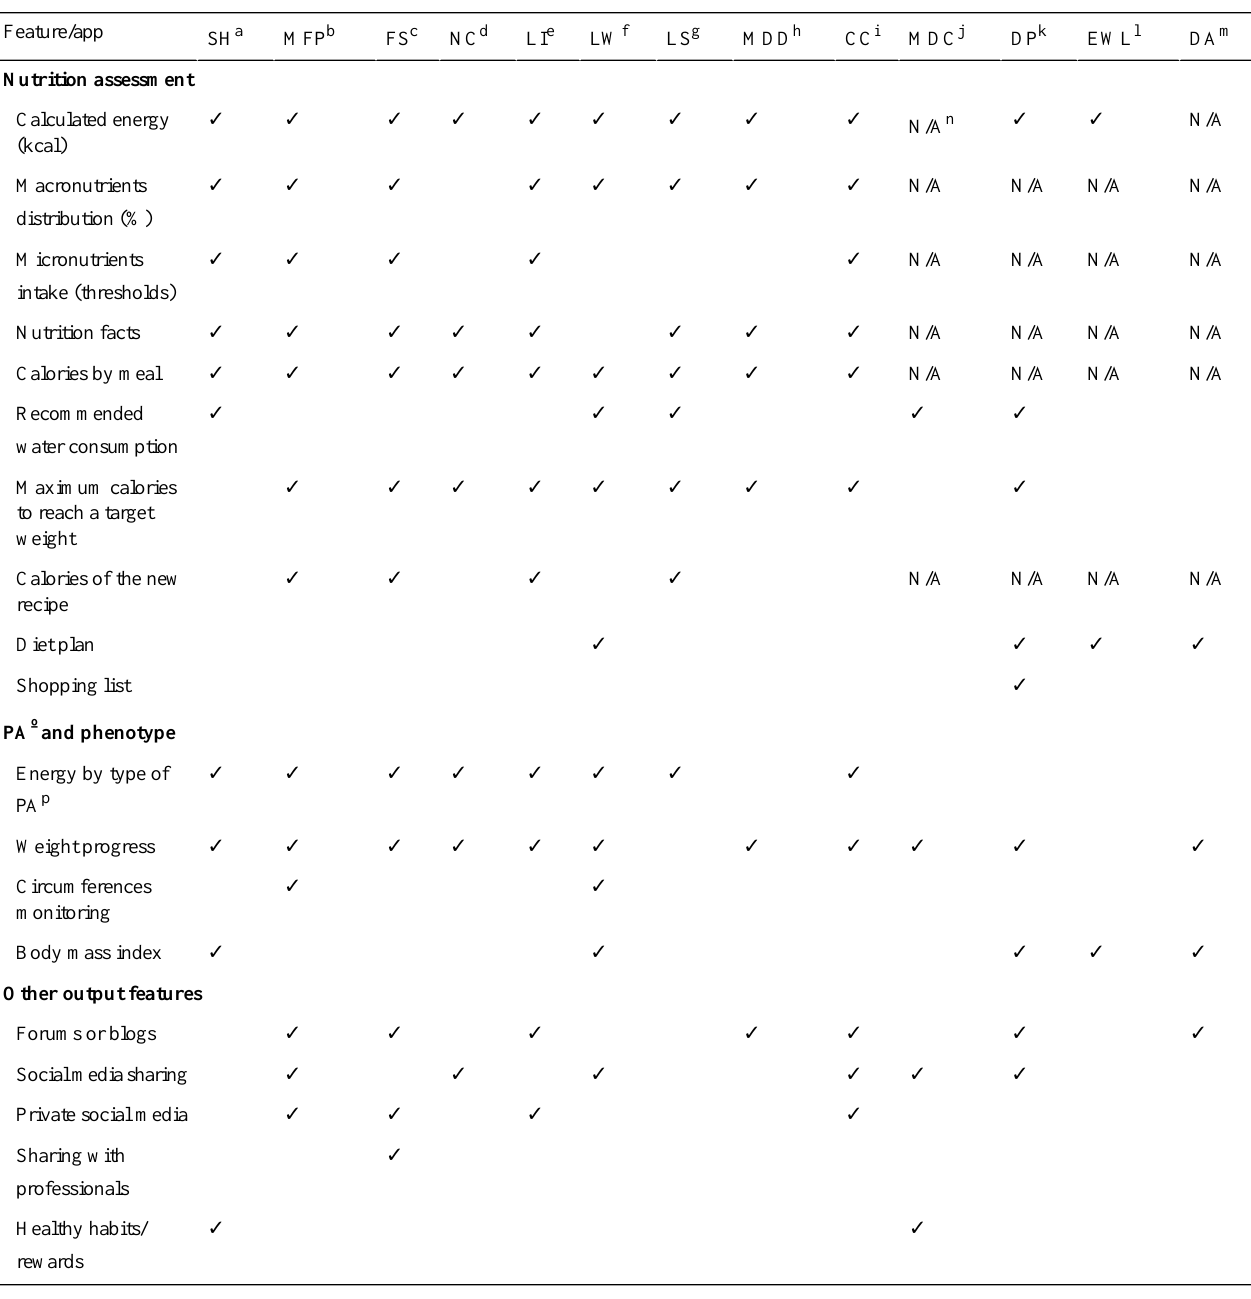
Table 5. Nutrition-related app output